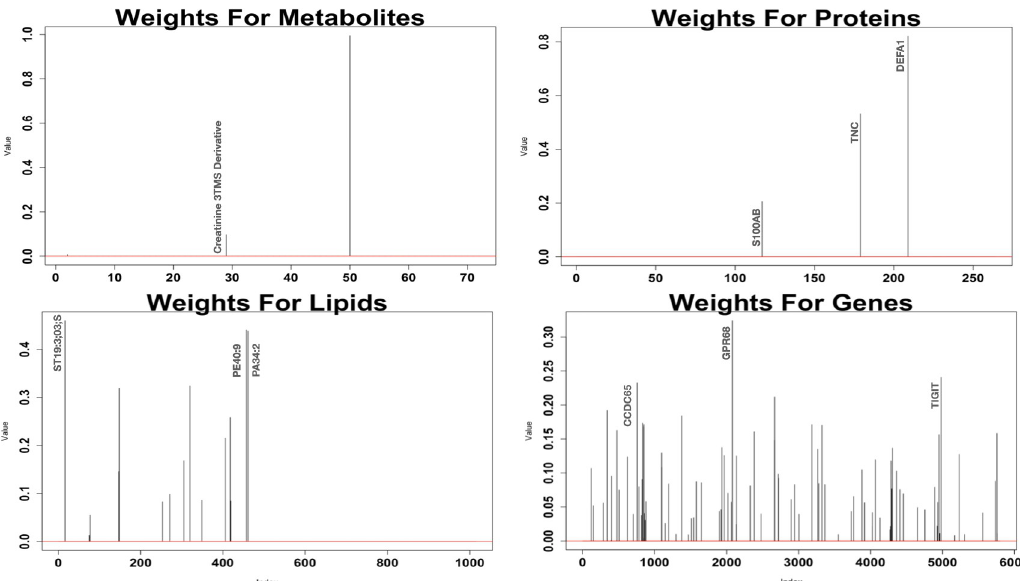
Fig 12. Absolute coefficients for first component of smCCA. These plots contain the absolute values of the weights for each datasets’ first component in smCCA.